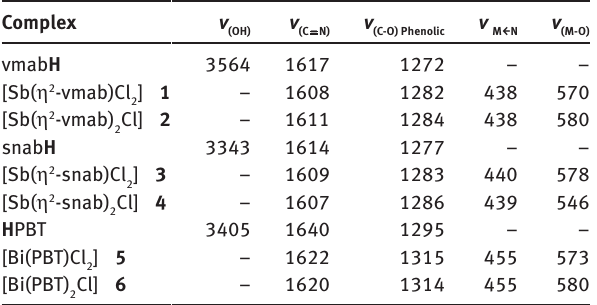
Table 2: Characteristic IR frequencies (cm −1 ) of new antimony(III) and bismuth(III) complexes 1–6 .